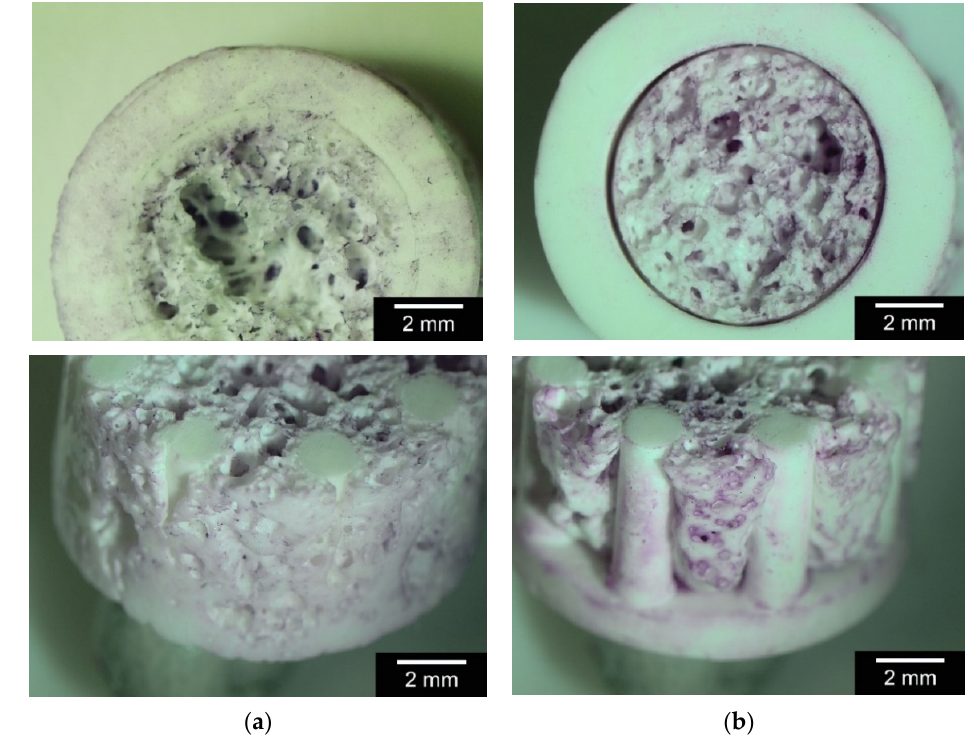
Figure 15. GIEMSA staining after ( a ) 3 and ( b ) 10 days; top and side view.